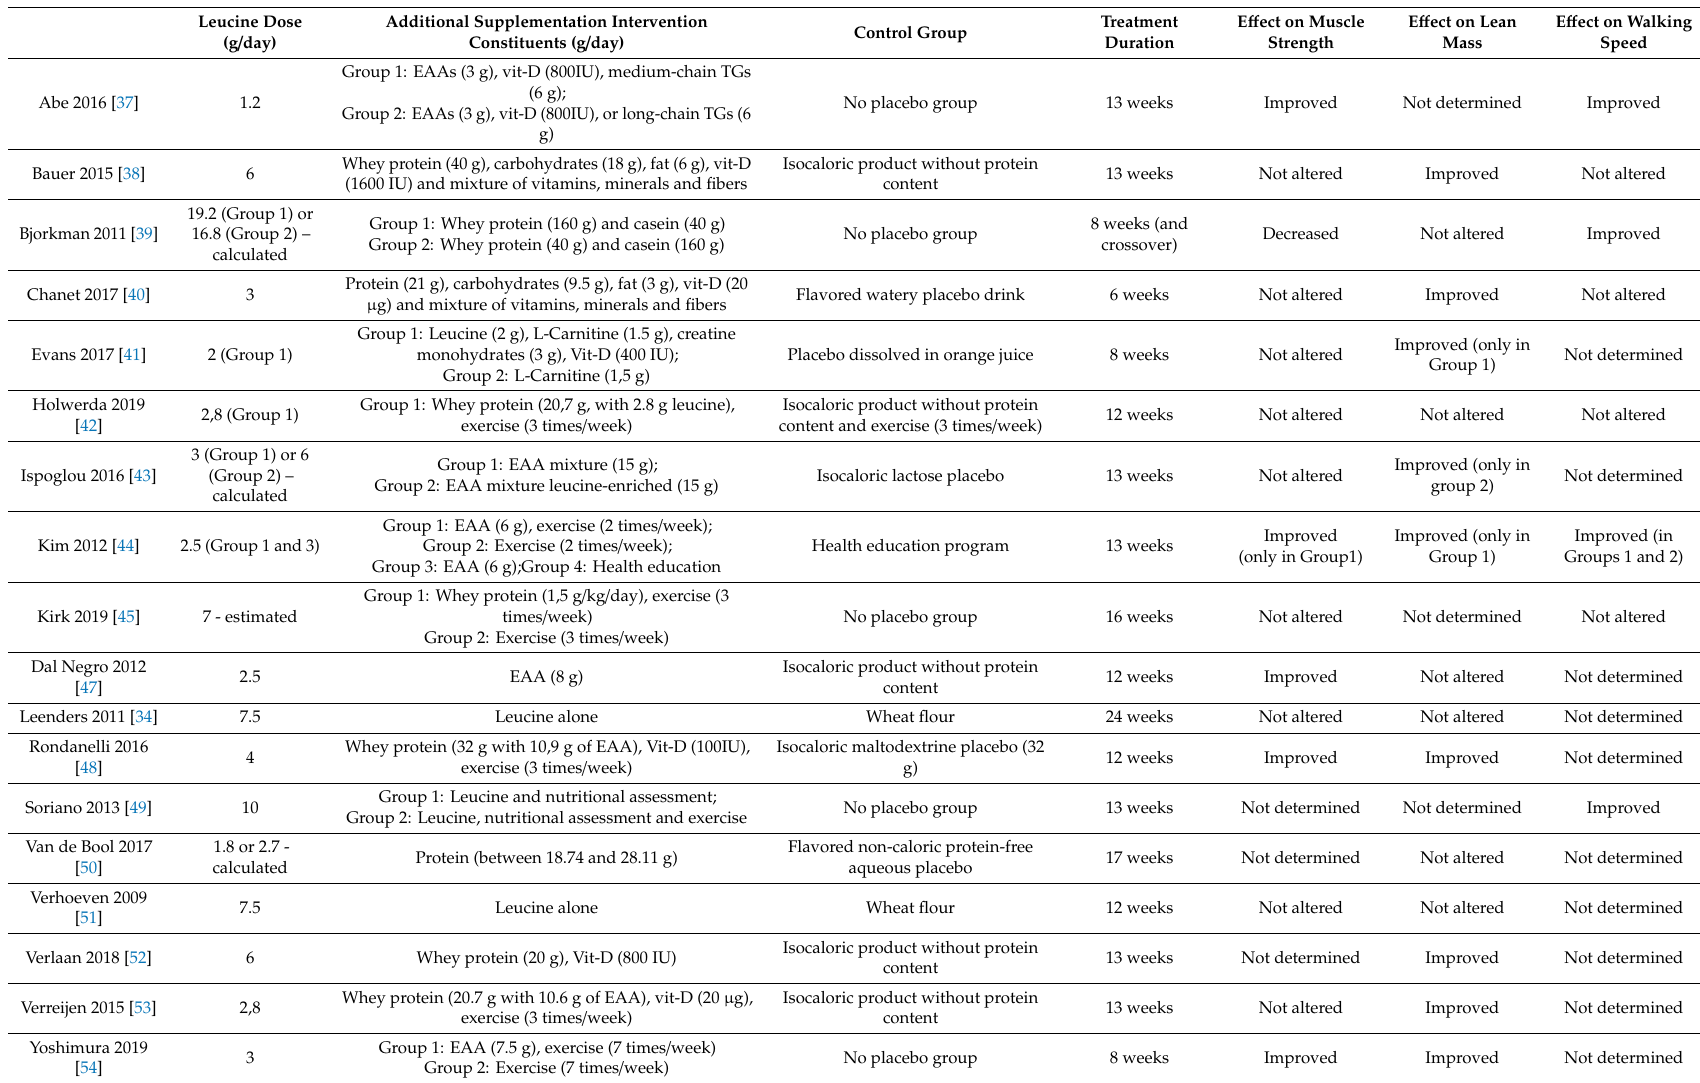
Table 2. Characteristics of leucine and placebo administration and e ff ects on the three sarcopenia